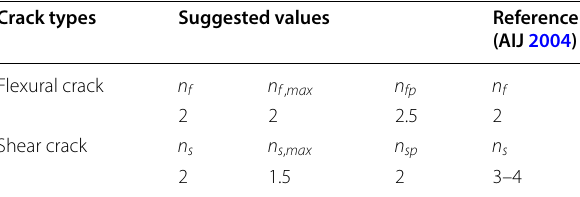
Table 7 Suggested values of n